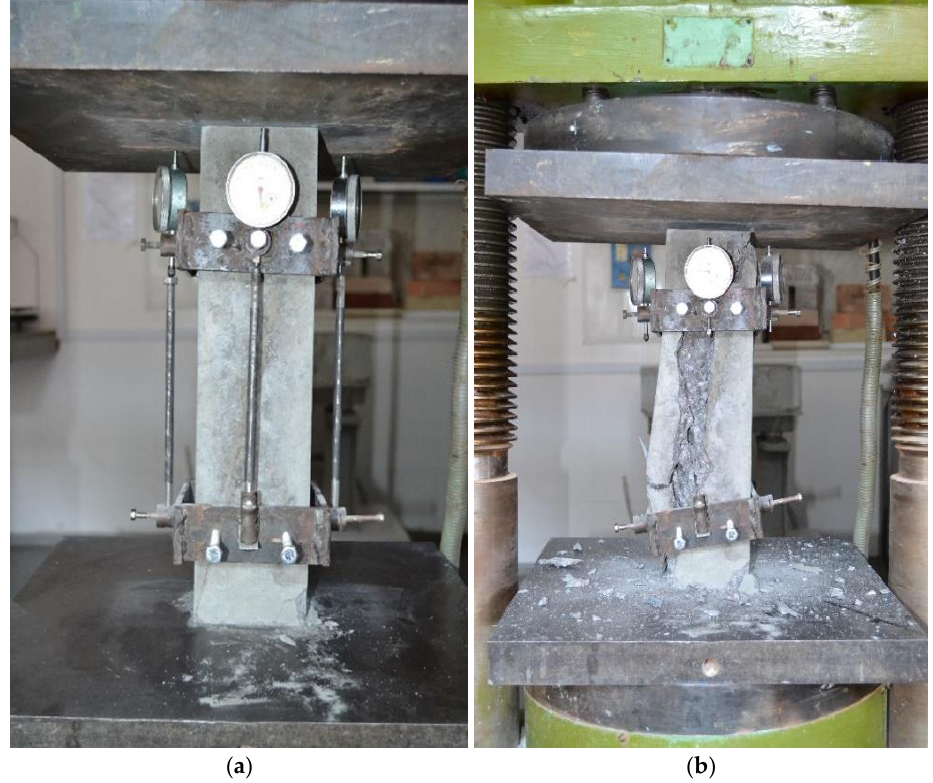
Figure 3. The collapse of the sample column during the test: ( a ) moment at the beginning; ( b ) final stage.